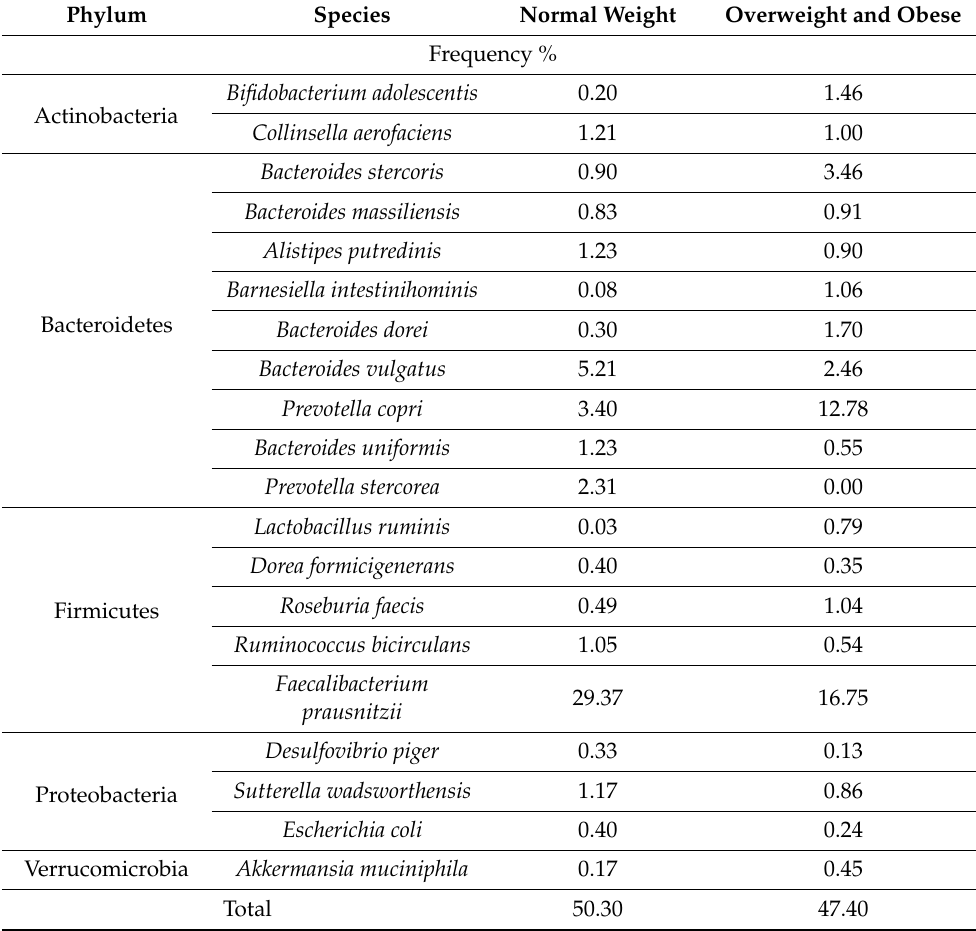
Table 2. Most frequent species in DNA samples from adolescents with different BMI status. Phylum